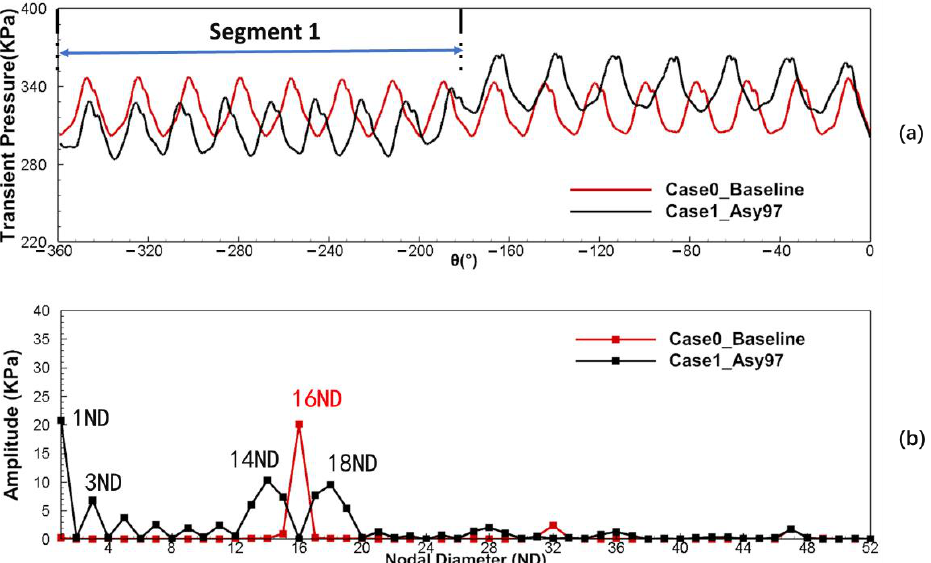
Figure 13. ( a ) Circumferential distributions of transient pressure at the vane exit; ( b ) Spatial spectra of the transient pressure at the vane exit. of the transient pressure at the vane